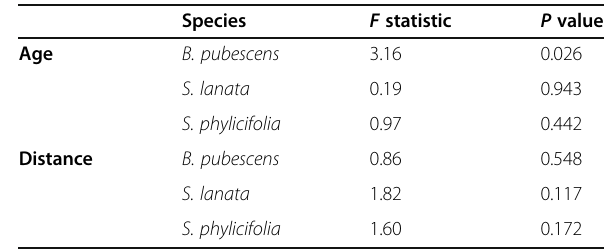
Table 3 One-way ANOVA results analyzing variance in data for mean size of B. pubescens , S. lanata , and S. phylicifolia grouped by age of the moraines where measured and by distance from Skaftafelsheiði,